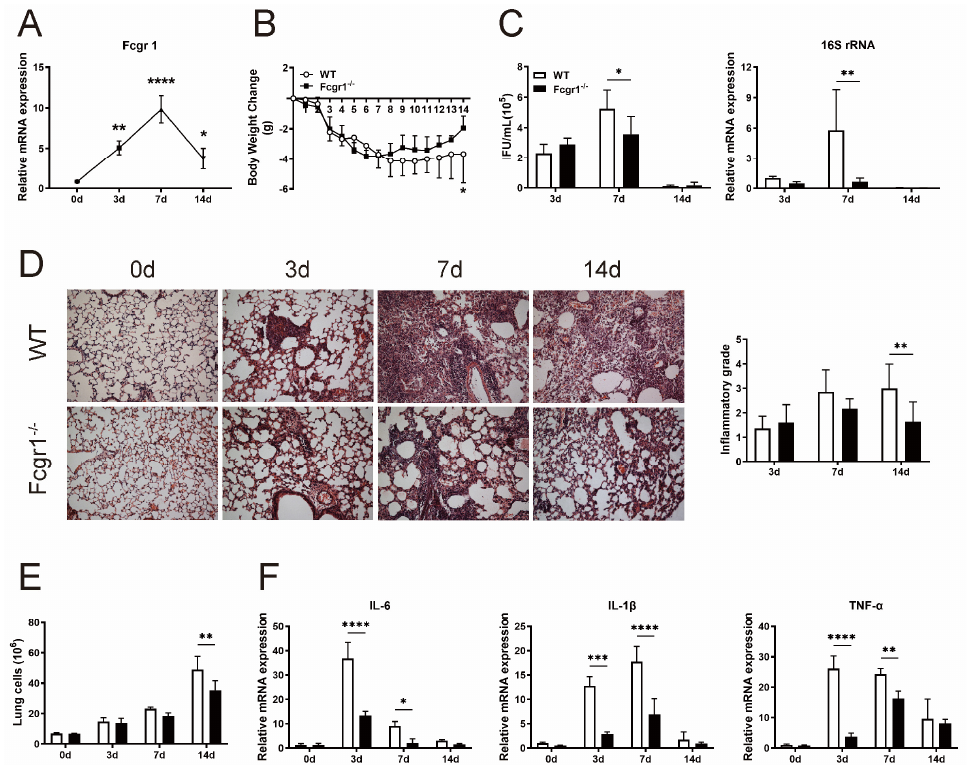
Figure 1. Increased resistance of FcγRI deficient (Fcgr1 −/− ) mice to Chlamydia muridarum ( C. muri- darum ) respiratory infection. ( A ) C57 BL/6 mice were intranasally infected with 1 × 10 3 inclusion